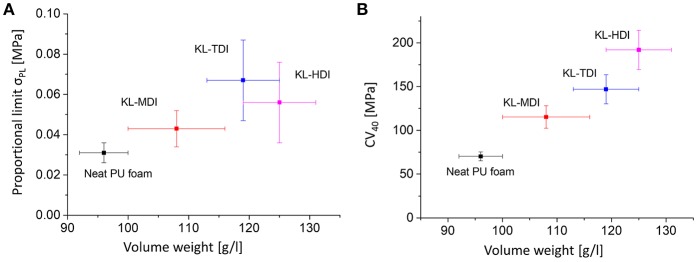
(A) Proportional limit σPL of the different foams vs. the volume weight. (B) CV40 values of the different foams vs. the volume weight.